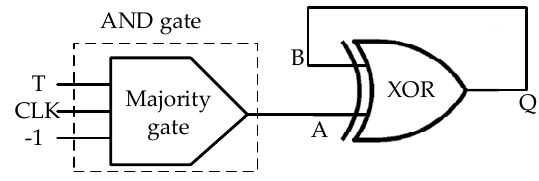
Figure 7. Schematic diagram of an LST-FF [16].